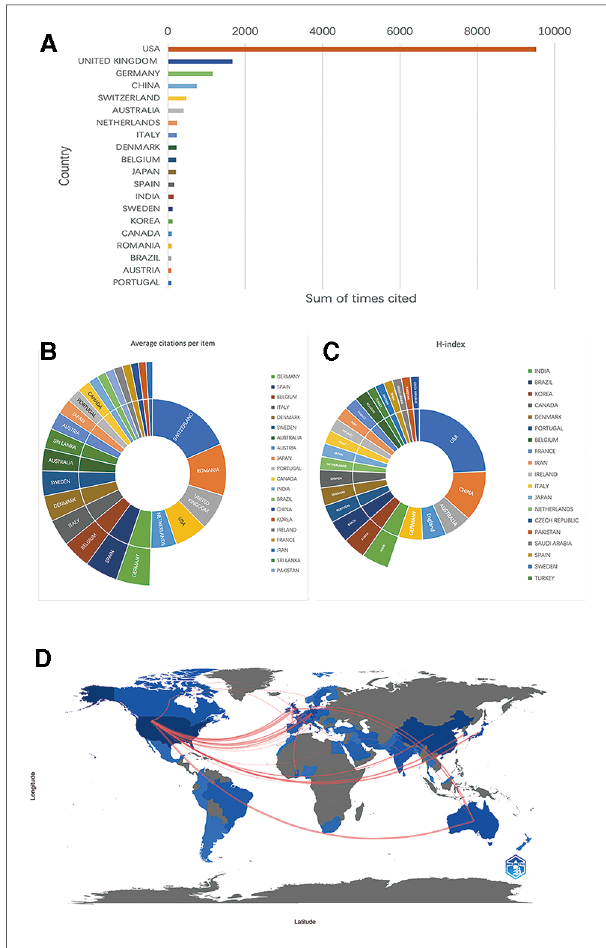
FIGURE 3 ( A ) The top 20 countries/regions of total citations. ( B ) The top 20 countries/regions of the average citations per paper. ( C ) The top 20 countries/regions of the H-index. ( D ) The geographical network map of cooperative relations between countries.